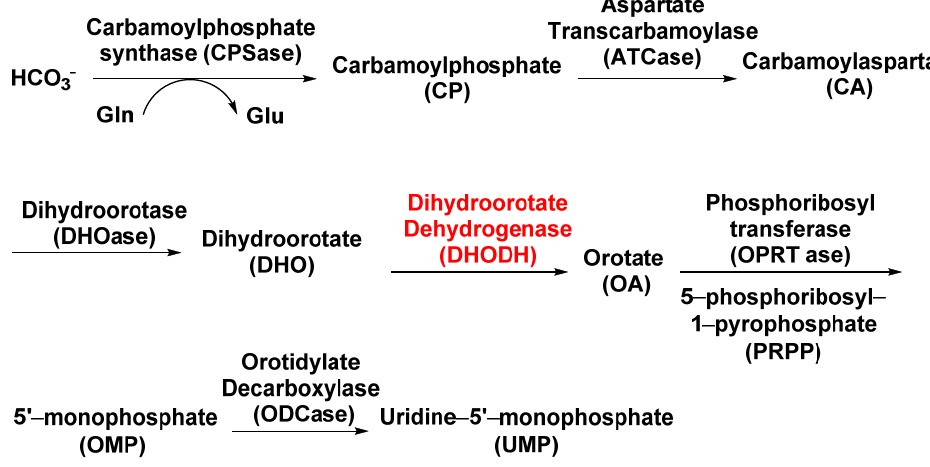
Figure 3. The biosynthesis pathway of the pyrimidine nucleotide. The potential herbicide target is indicated by the red color. indicated by the red